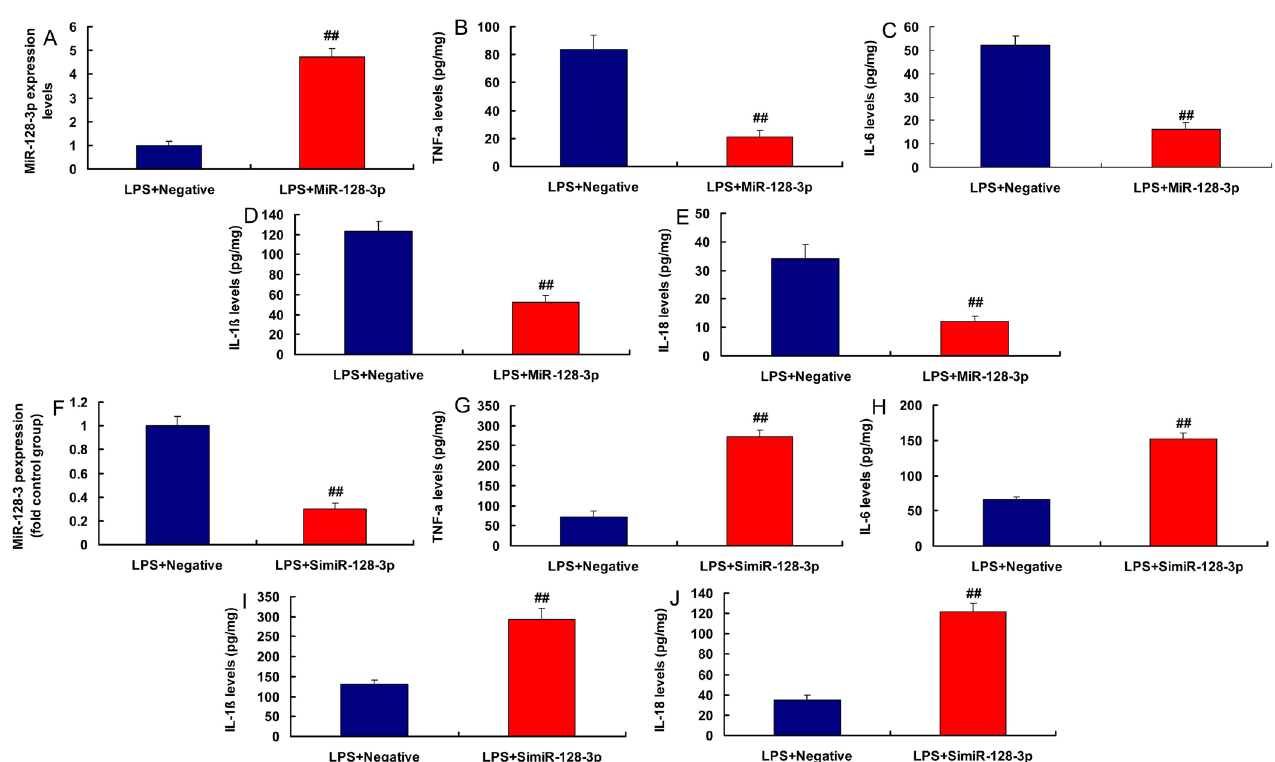
Fig. 5 - Micro ribonucleic acid (MiR)-128-3p regulated inflammation in the in vitro model. MiR-128-3p expression (A), tumor necrosis factor alpha (TNF-α), interleukin (IL)-6, IL-1β, and IL-18 (B, C, D, and E) in overexpression of miR-128-3p group; miR-128-3p expression (F), TNF-α, IL-6, IL-1β, and IL-18 (G, H, I, and J) in downregulation of miR-128-3p group. LPS+Negative, LPS-induced in vitro model by negative mimics group; LPS+miR-128-3p, LPS-induced in vitro model by miR-128-3p group. ## P<0.01 compared with LPS+Negative group.